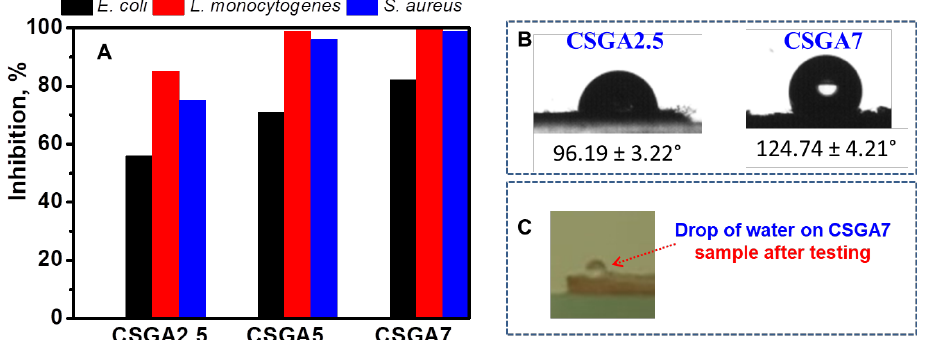
Figure 8. Antimicrobial activity of CS-based cryogels ( A ). Contact angle values for the CSGA2.5 and CSGA7 cryogels ( B ). Optical images of a water drop on the surface of a CSGA7 cryogel after the contact angle measurements ( C ).